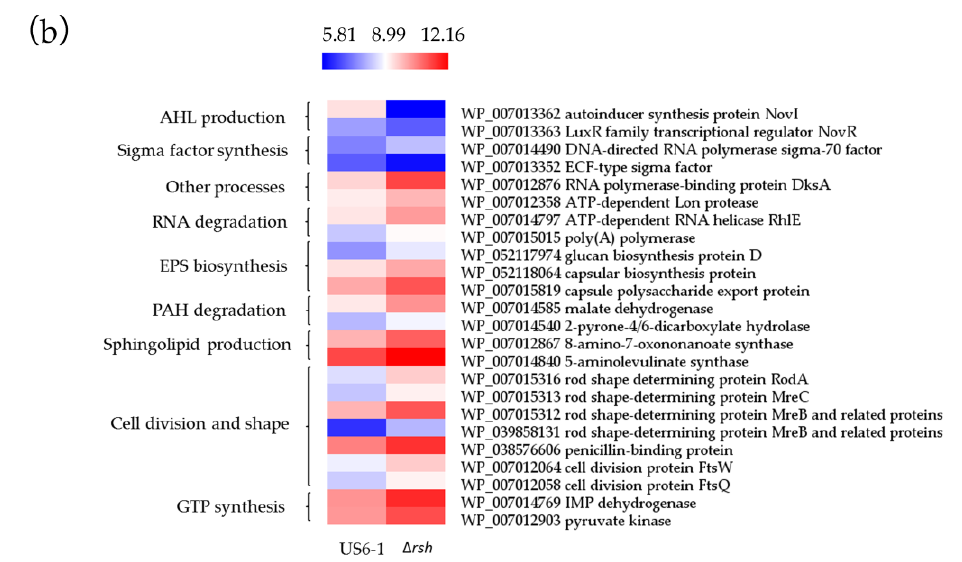
Figure 4. Differentially expressed genes (DEGs) overview (∆ rsh vs. US6-1) in the RNA-seq data. ( a ) Over-represented Kyoto Encyclopedia of Genes and Genomes (KEGG) categories. KEGG annotation and pathway enrichment analysis was performed using the KEGG pathway database (http://www.genome.jp/kegg/). The p values denote the enriched levels in a KEGG pathway, which was calculated using a Fisher’s exact test [42]. Up- and down-regulated genes (∆ rsh vs. US6-1) are represented by red and blue bars respectively, representing the number of genes per functional category. ( b ) Heat map of log 2 expression ratios of specific DEGs involved in AHL production, sigma factor synthesis, RNA degradation, EPS biosynthesis, PAH degradation, sphingolipid production, cell division and shape, GTP synthesis and other functions in strain US6-1 and ∆ rsh . Expression values are reflected by red-blue coloring as indicated. The heat map was drawn by the software HemI [43].